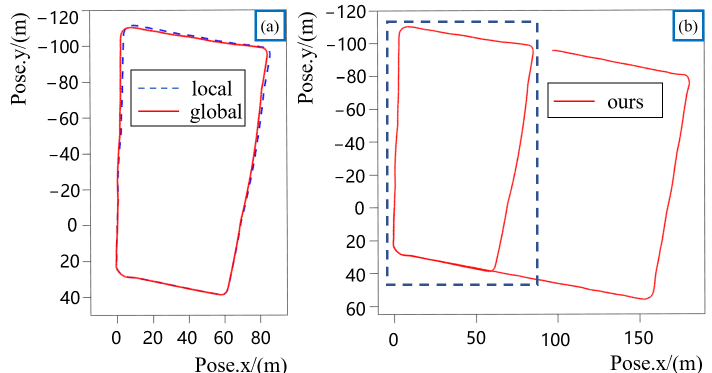
Figure 5. Trajectory results on our dataset. Trajectory ( a ) shows the comparison of the trajectory with loop closure constraint and the trajectory without loop closure constraint of the road segment designed with loop closure. Trajectory ( b ) shows the complete trajectory.